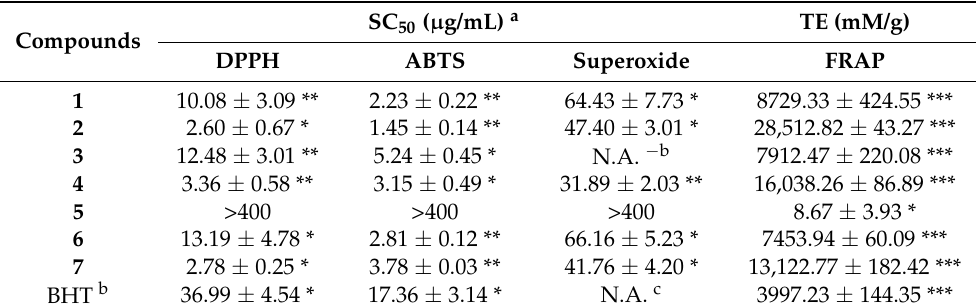
Table 5. Antioxidant effects of isolated compounds from Ampelopsis japonica measured with DPPH, ABTS, superoxide radical scavenging, and FRAP assays.